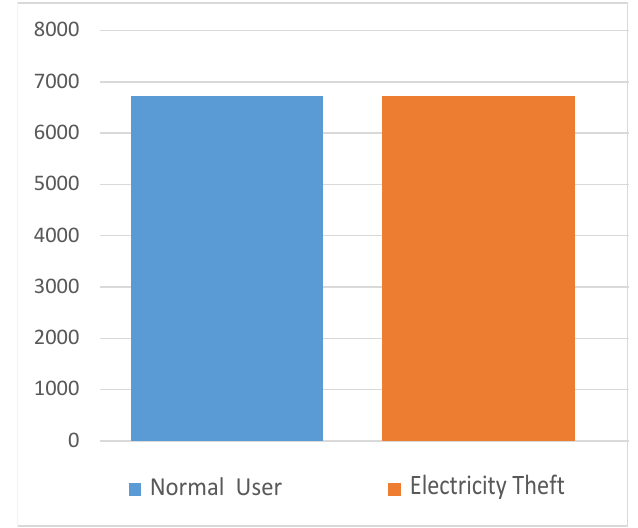
Figure 5. Data after applying Synthetic Minority Oversampling TEchnique (SMOTE)